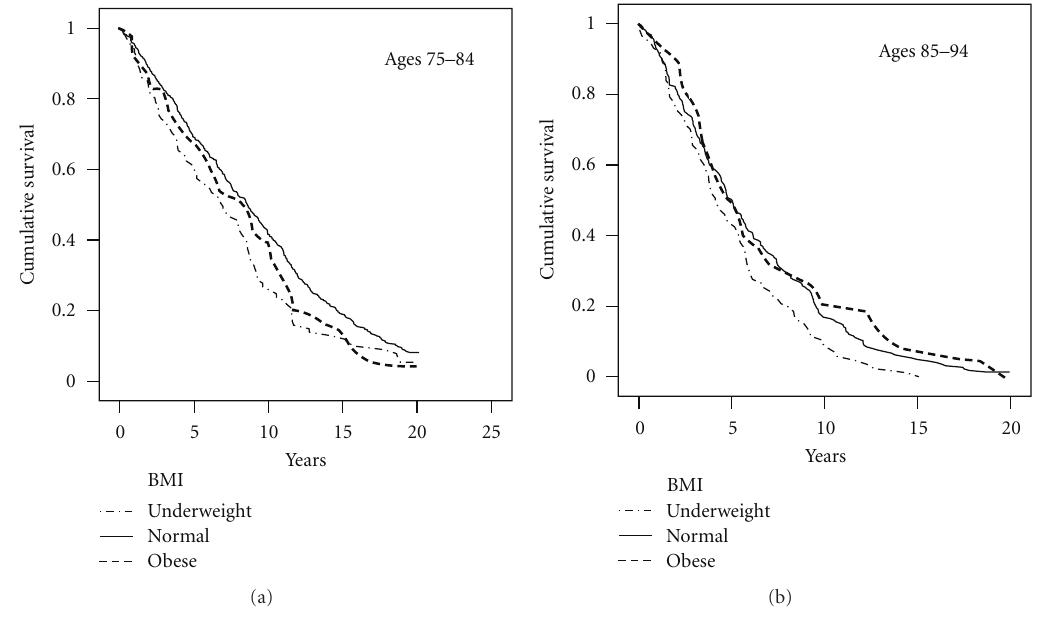
Figure 1: Kaplan-Meier Survival Curves according to Body Mass Index (BMI) in community dwellers. Obesity was significantly predictive of higher mortality for persons aged 75–84, but not for 85–94. Being underweight was consistently predictive of mortality. BMI < 22 = underweight, 22–30 = normal, > 30 =